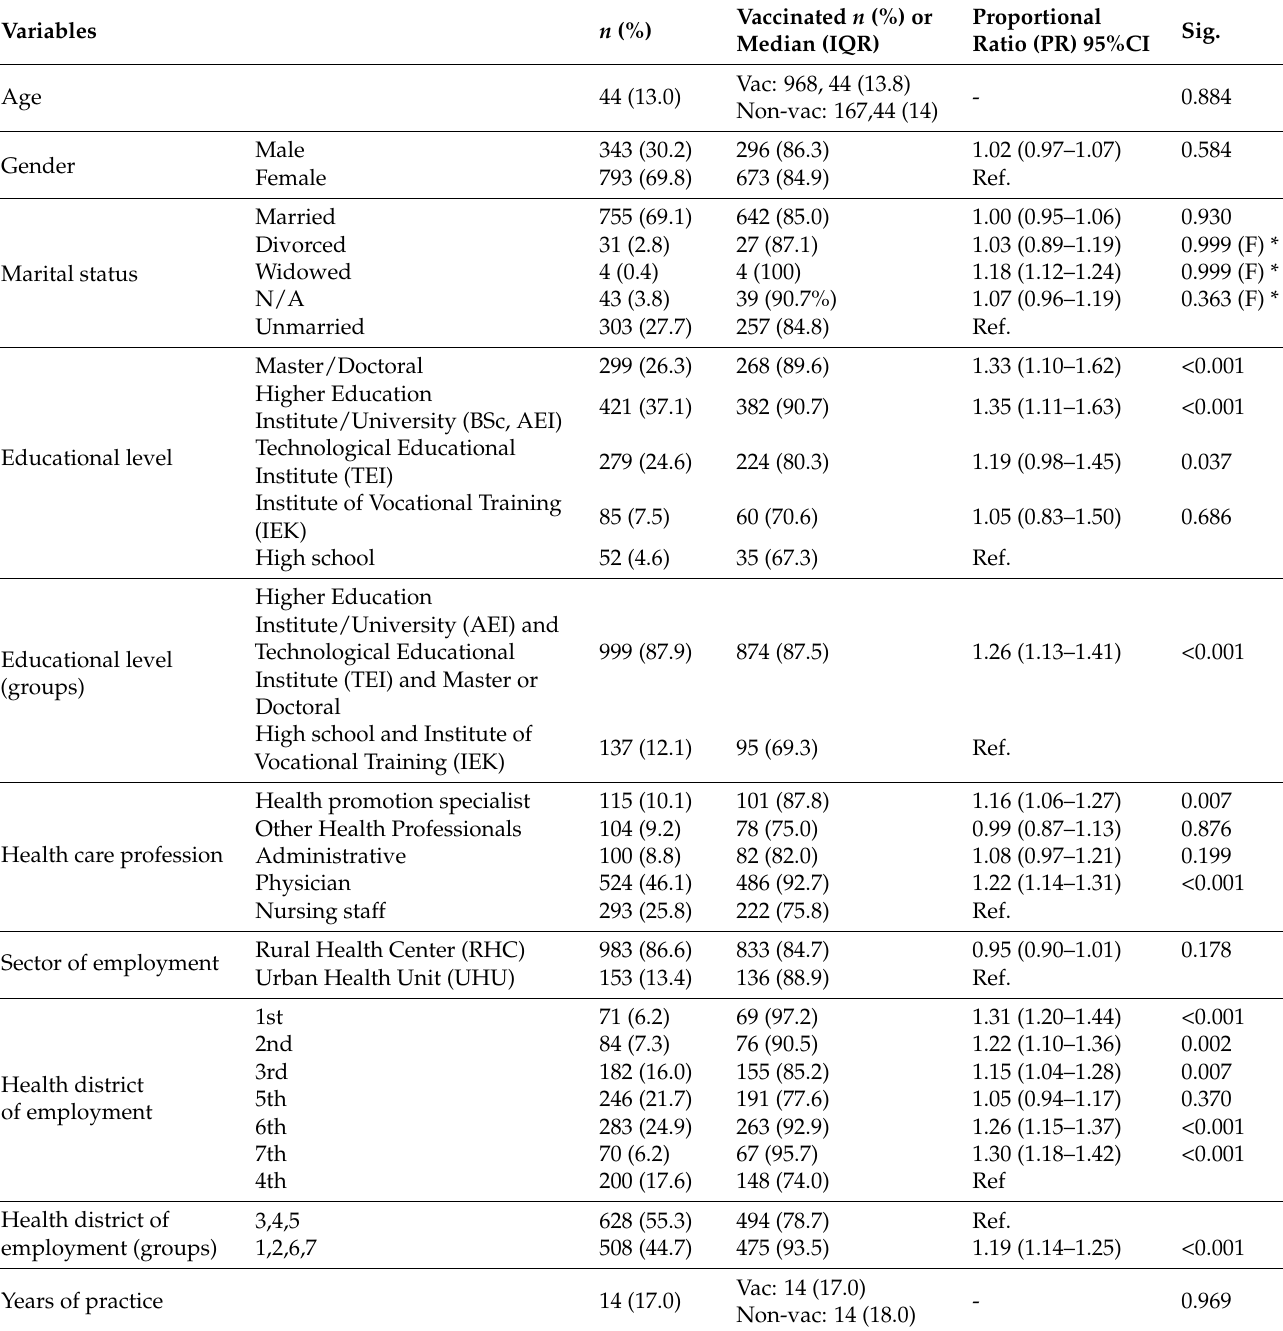
Table 1. Demographic characteristics associated with COVID-19 vaccine acceptance, expressed with proportional ratio (PR) in univariate analysis (Total number of respodents